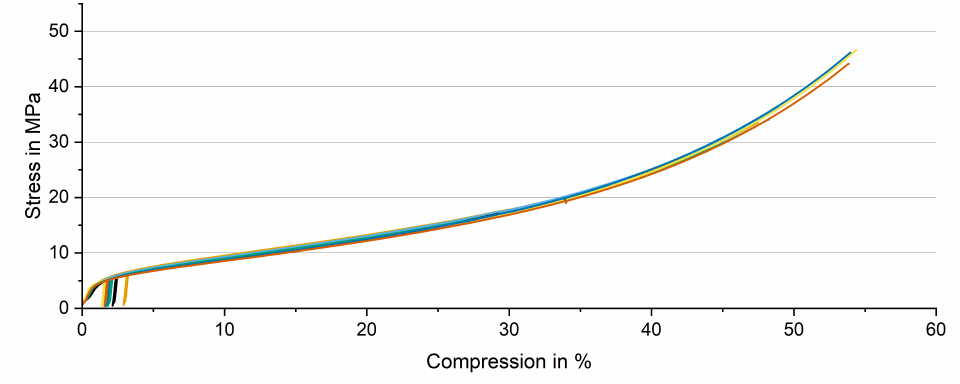
Figure 4. Results of compression tests of PA80 − 110, first measurement